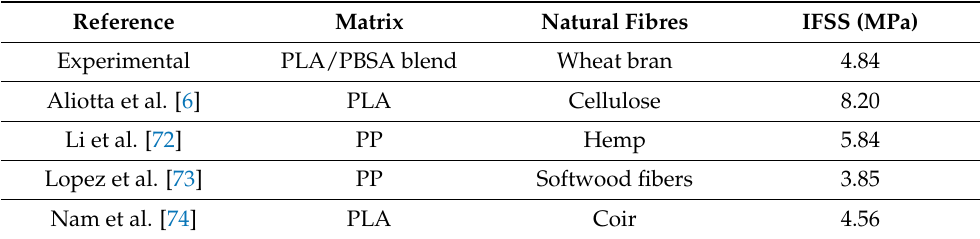
Table 3. IFSS obtained for the composites system analyzed compared with literature data of similar systems.